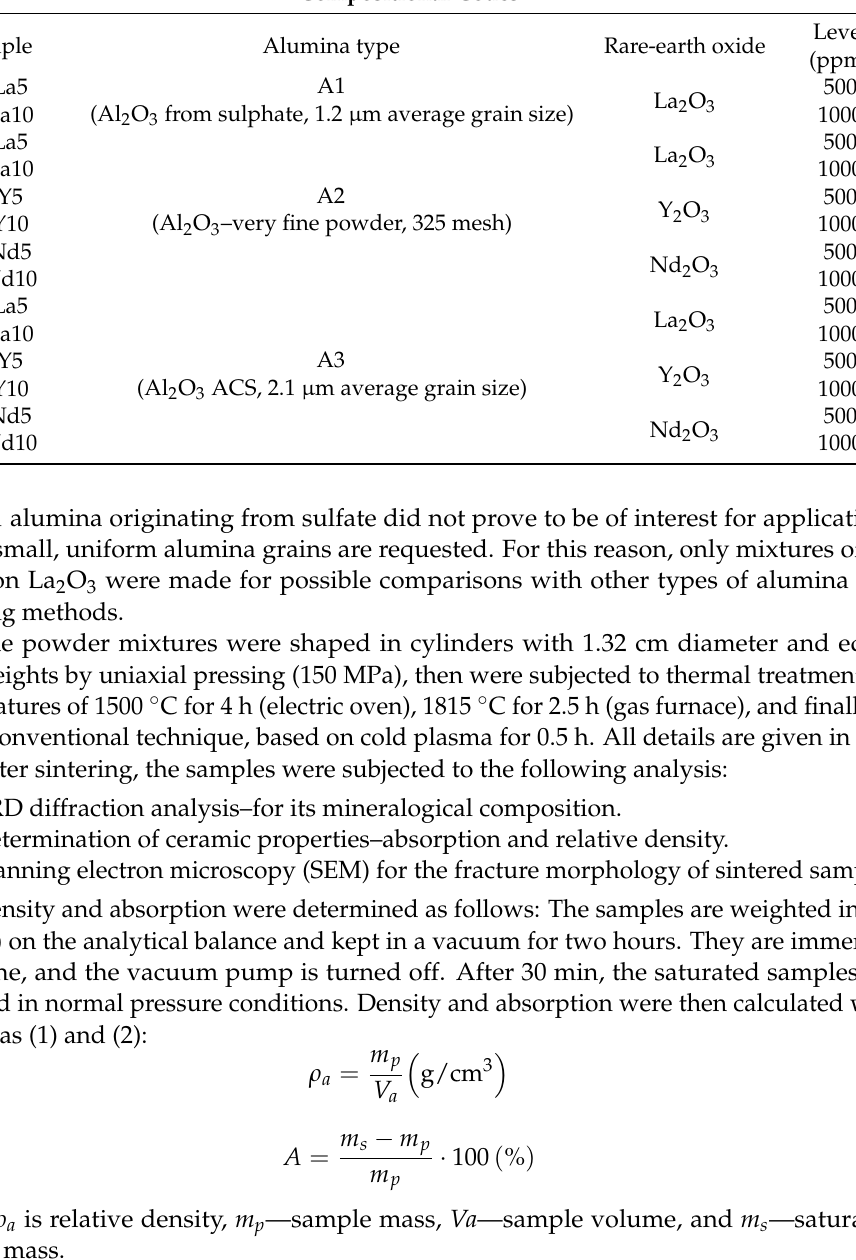
Table 1. Compositional codes and concentration levels of dopants. Compositional